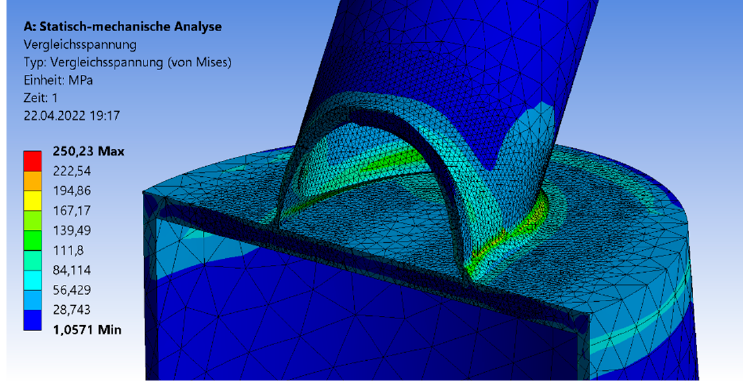
Figure 3. Von ‐ Mises stress detailed over cross ‐ section.